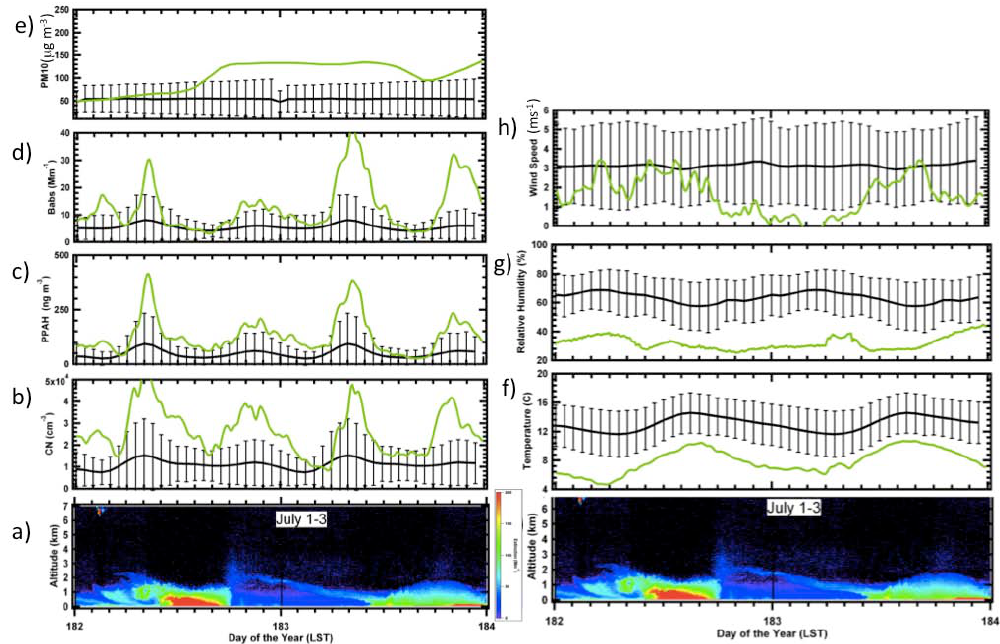
Fig. 4. Time series for the period 1–2July, 2011 showing (a) the vertical profile of aerosol extinction (in Mm − 1 , red indicates the highest values), (b) CN concentration, (c) PPAH concentration, (d) absorption coefficient, (e) PM 10 , (f) temperature, (g) relative humidity and (h) wind velocity. The black solid lines are the daily average background from days with no volcanic ash and the vertical bars are one standard deviation. The green lines show the ten-minute averages observed those days. The tick marks in the horizontal axes correspond to